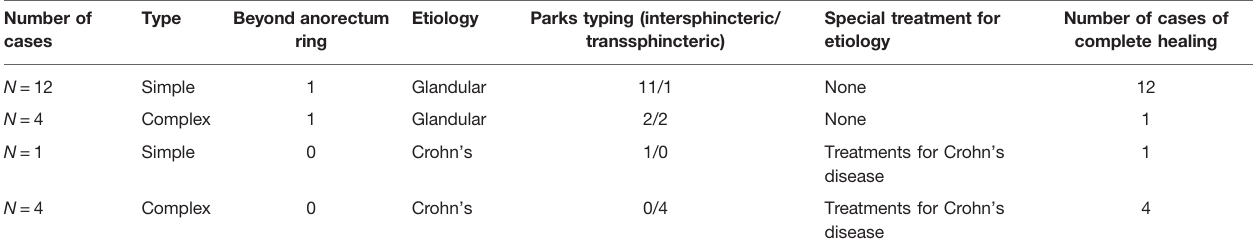
TABLE 1 | Classi fi cation of fi stula by type, etiology, and relative